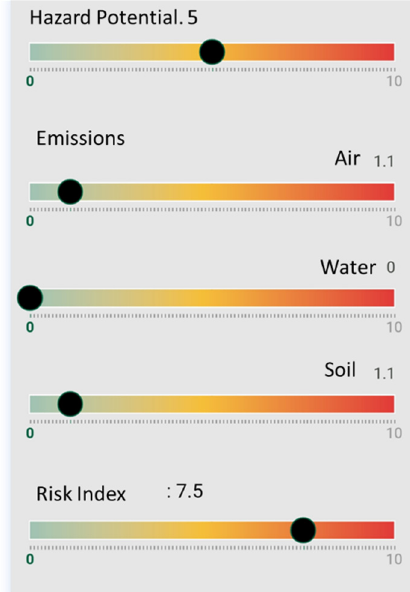
Figure 10. Excerpt from the report generated with the NanoSerpa v1.0 app for a fall of eight TiO 2 bulk bags on the road. These results apply only to the exposure area where the events studied have occurred.